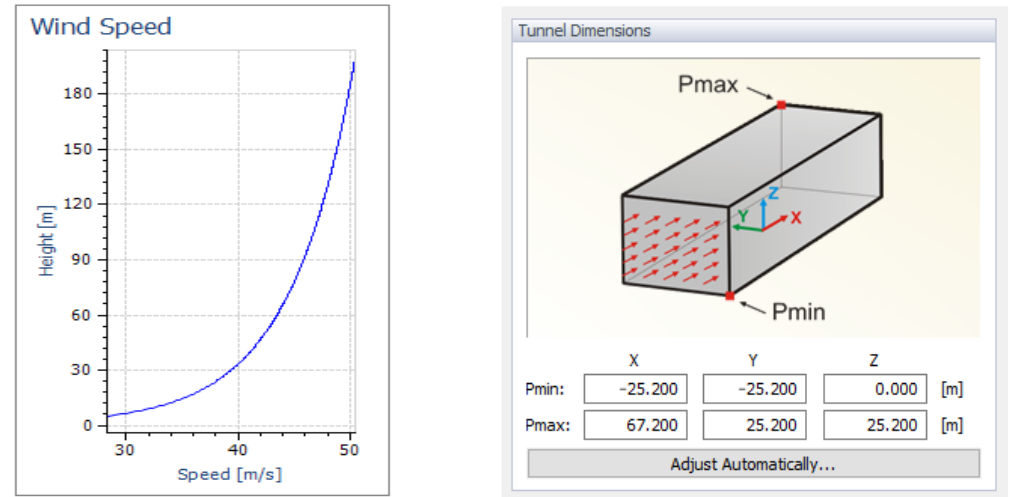
Figure 8. Wind speed in height ( left ), dimensions of the wind tunnel generated ( right ).